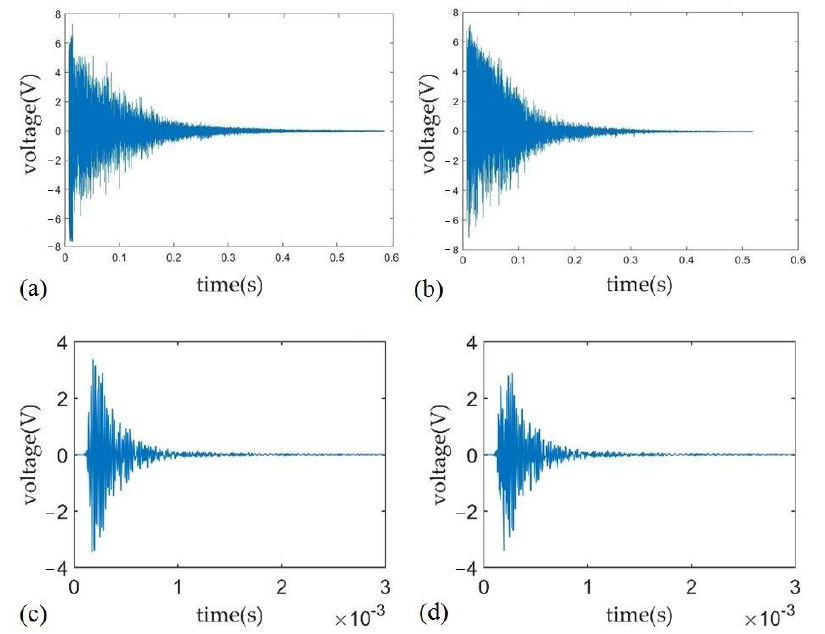
Figure 10. Comparison between simulated signals and measured signals (type 1). ( a ) Simulated broken wire signal, ( b ) Broken wire signal, ( c ) Simulated non-broken wire signal, ( d ) Non-broken wire signal.